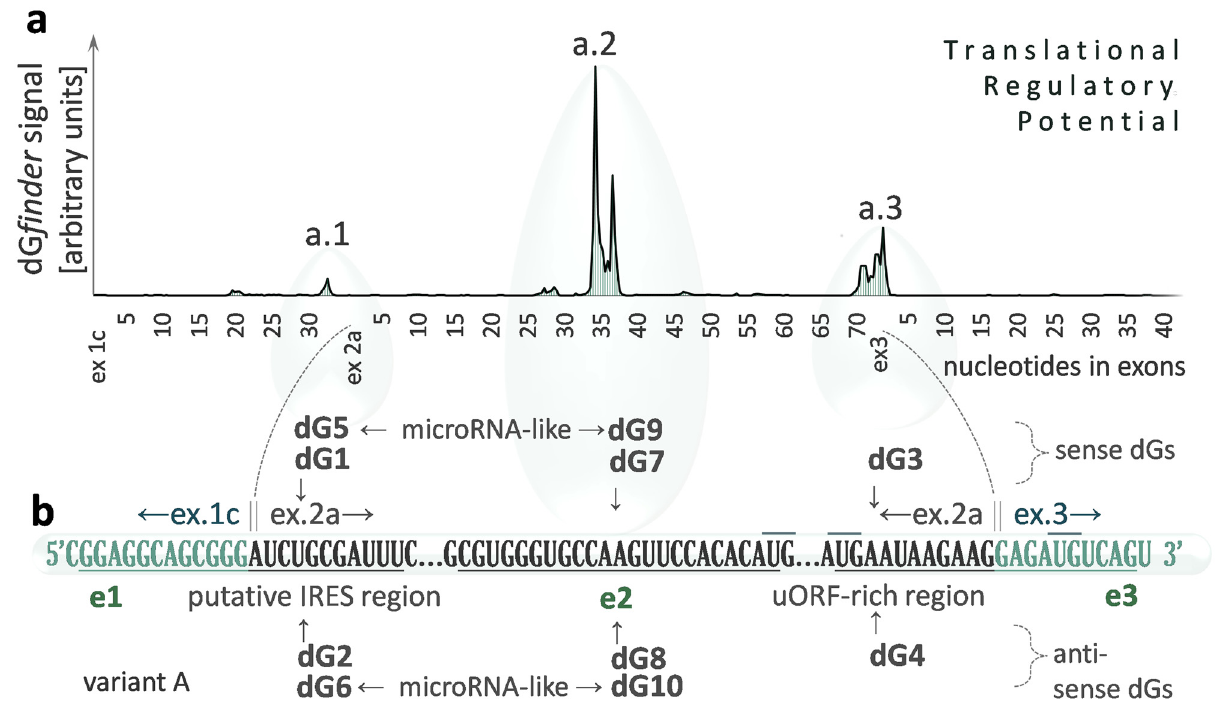
Fig 2. dGoligo recognition sites. ( a ) Cis -acting elements (e1, e2, e3) of variant A of TR β 1 5 ’ UTR determined by dGenhancer, which indicates signal maxima (a.1, a.2 and a.3) corresponding to the 5 ’ UTR fragments with the highest translational regulatory potential. The signal intensity represents transformed mean of 6 consecutive changes in Gibbs energy ( Δ G) observed among 5 ’ UTR sequences containing artificial SNPs. The SNPs were used as a theoretical model to calculate which sequence fragments (within the UTR) can change Δ Gs (of the UTR) the most, thereby affecting the translational potential of the 5 ’ UTR. ( b ) dGoligo (dGs 1 – 10) targets (e1, e2, e3) in TR β 1 5 ’ UTR are shown as underlined sequences. dGs are presented above (sense) and below (antisense) the TR β 1 5 ’ UTR A. Each dG shares homology with the TR β 1 5 ’ UTR, targeting one of the indicated sequences: a putative IRES site on ex1c/ex2a junction (underlined) targeted by dG1, dG2, dG5, dG6, a sequence containing multiple alternate AUGs (uORFs-rich region) and located on ex2a/ex3 junction targeted by dG3, dG4 or a sequence in the middle of exon 2 targeted by dG7 dG8, dG9 and dG10. All dG s were designed as complementary pairs of antisense strand (dG2, dG4, dG6, dG8, dG10) directly recognizing the indicated region and sense strand (dG1, dG3, dG5, dG7, dG9) that can bind to distant sequences that interact through complimentary base-pairing with the indicated region (S1 Fig). Oligonucleotides dG5, dG6, dG9 and dG10 were synthesized as microRNA-like oligonucleotides with 3-nt insertion in the middle of their